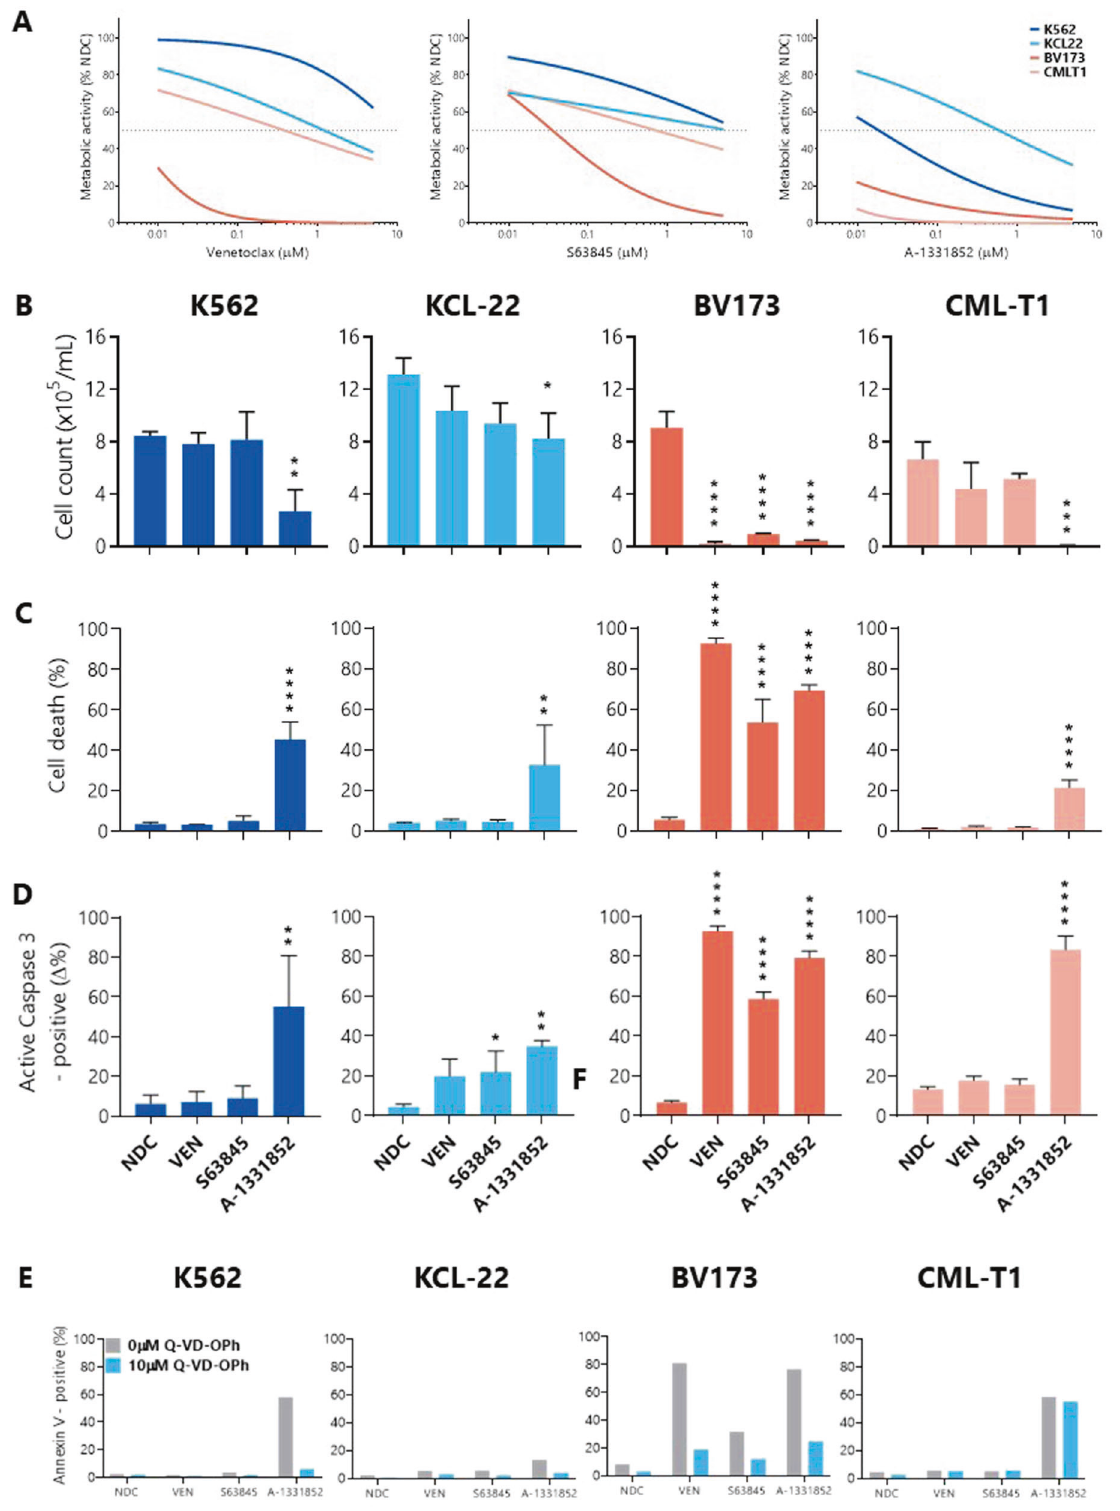
Fig. 1 BCL-xL inhibition reduces cell viability and induces apoptosis in BP-CML cell lines. A BP-CML cell lines were treated for 72 h with increasing concentrations of venetoclax (VEN; ABT-199), S63845, or A-1331852 before incubation with resazurin. Lines of best fi t for means of replicates, N = 3, dotted line indicates 50% inhibition. B Cell lines were treated with 1 µM of each indicated BH3 mimetic for 72 h before viable cell counts, Annexin V/DAPI staining ( C ), and active caspase-3 staining ( D ) were measured ( N = 3). E BP-CML cell lines were pre-treated with the pan-caspase inhibitor Q-VD-OPh (10 µM) before 1 µM BH3 mimetic treatment for 72 h and subsequent staining with Annexin V, N = 2. NDC, no drug control. One-way ANOVA, * p ≤ 0.05, ** p ≤ 0.01, *** p ≤ 0.001, **** p ≤ 0.0001. Data are represented as mean ± SD.